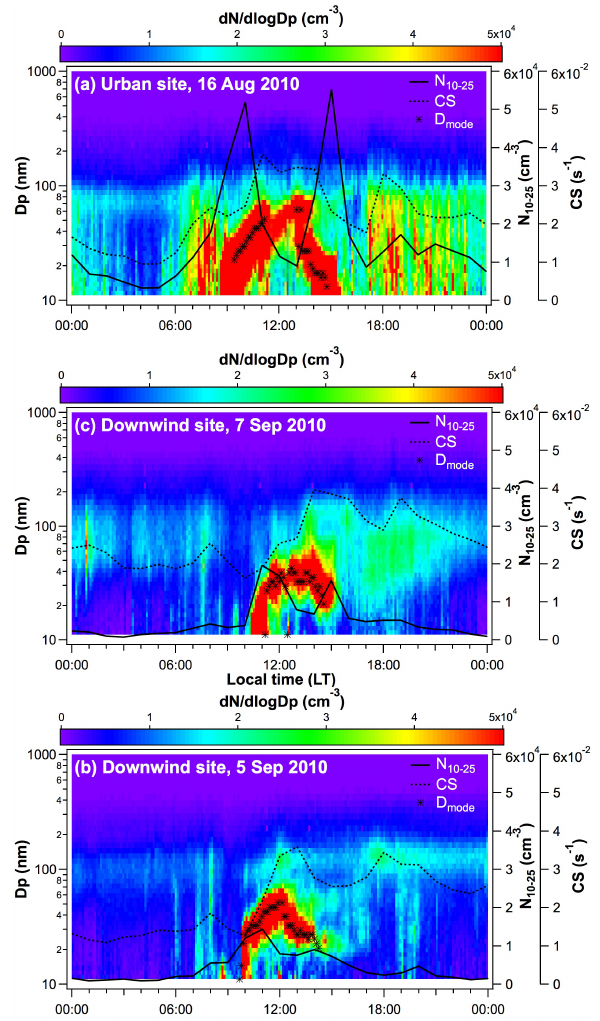
Fig. A1. The measured particle number size distributions, D mode (stars), N 10 − 25 (solid lines) and CS (dash lines) during the three other particle shrinkage events on the (a) 16 August, 2010, (b) 5 September 2010 and (c) 7 September 2010.